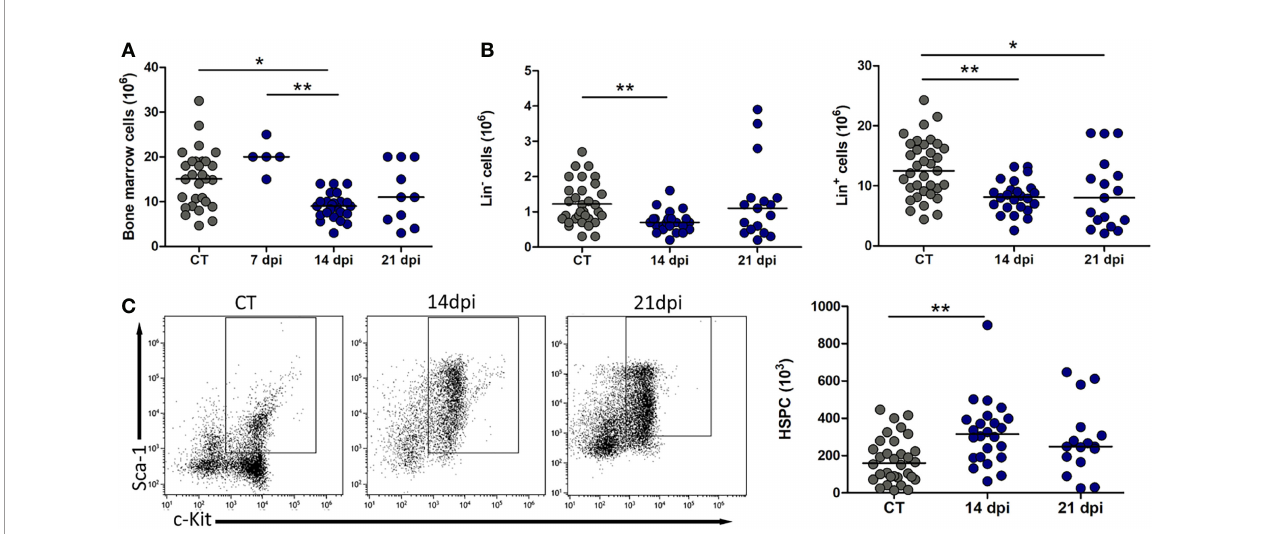
FIGURE 2 | Oral Trypanosoma cruzi acute infection alters bone marrow hematopoiesis. (A, B) A transient, yet signi fi cant, reduction in total cell numbers and the immature Lin − components. Total numbers of Lin + cells are also down at 14 dpi, but differently, remained lower than controls even at 21 dpi, as seen in Panel (B, C) Representative dot plots of Sca-1 versus c-kit expression gated in Lin − cells and HSPC absolute cell numbers, with phenotype Lin − SCA-1 + c-Kit + . Bars indicate the medians in each group; circles depict individual mice. The data comprised results from 5 infected animals at 7 dpi, or pooled from 5 independent experiments with 3 – 7 animals per analysis at 14 dpi, or pooled from 5 independent experiments with 2 – 7 animals per analysis at 21 dpi. All control animals were grouped in each setting. Control versus infected groups compared through a non-parametric Kruskal – Wallis ANOVA test with Dunn ’ s multiple comparison test. * p < 0.05, ** p <